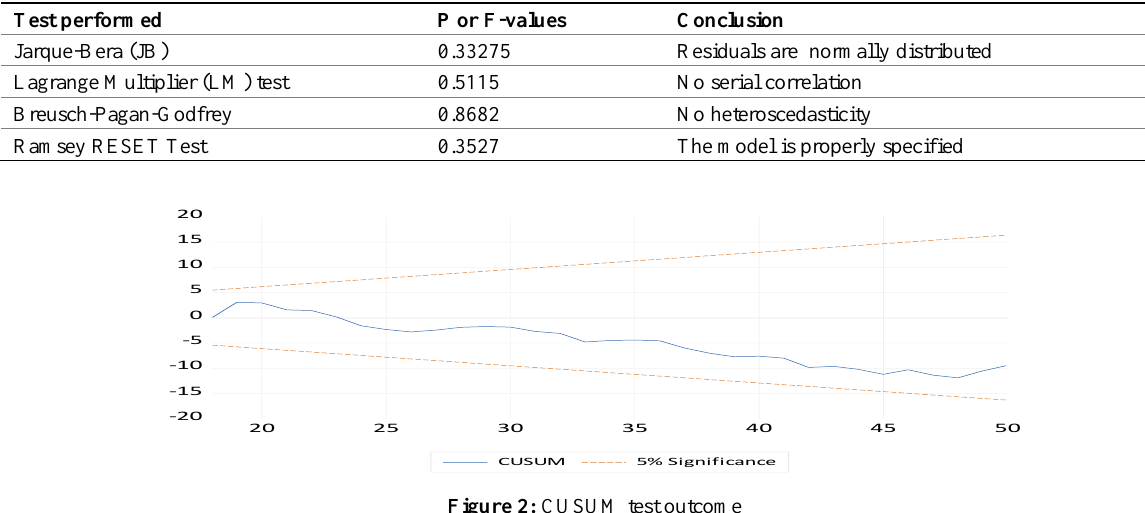
Figure 2: CUSUM test